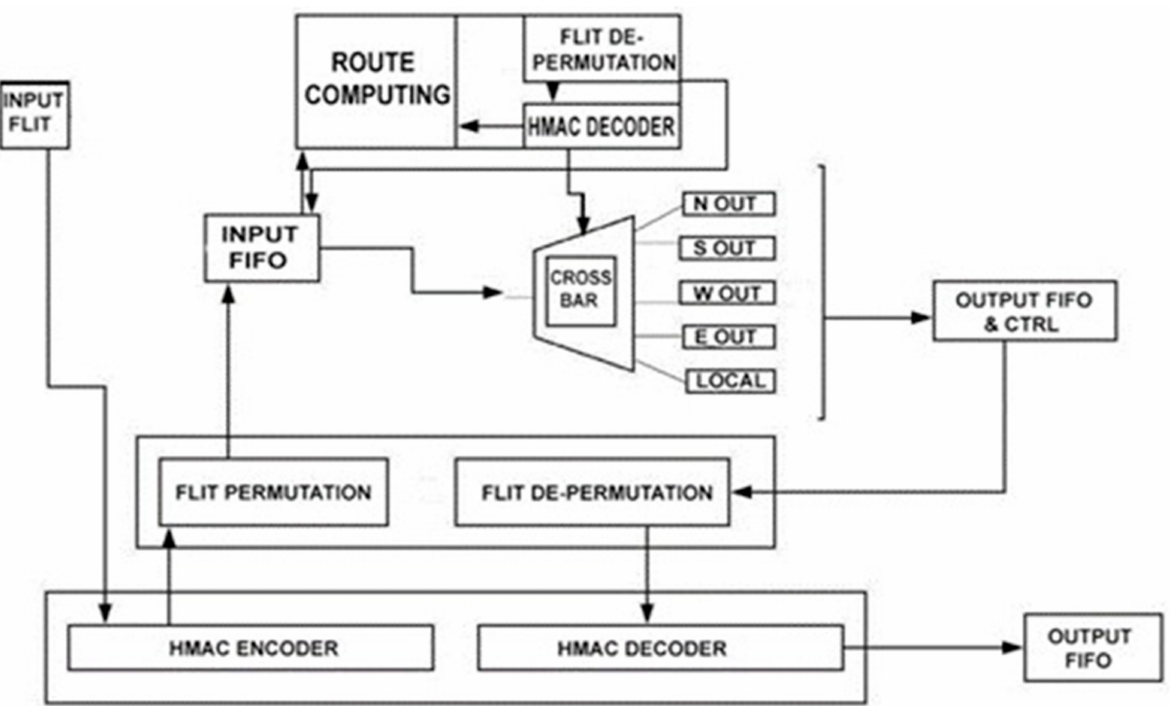
Figure 7. Proposed method for hardware Trojan detection and